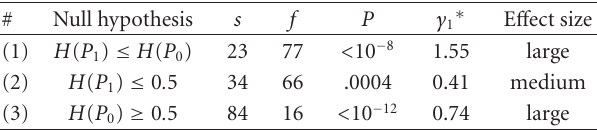
Table 4: Hypothesis tests where s and f are the number of success and failures for trials 101–200.